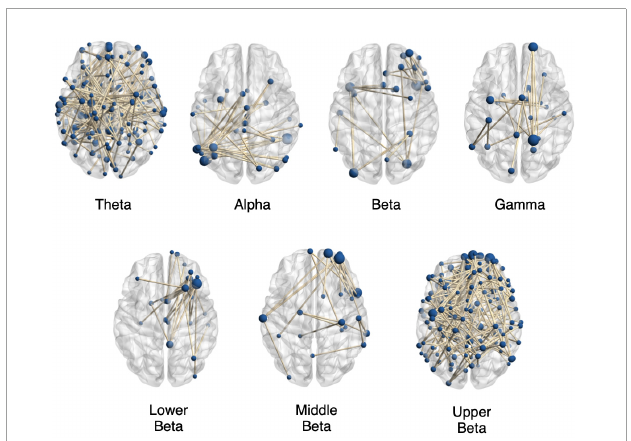
FIGURE2 Significantly altered brain networks in the autistic (autistic) group compared to the non-autistic group. The figure shows exemplary plots of networks with significantly altered functional connection strengths from various time windows during the FER task for positive emotions in the various EEG frequency bands for task 3.2 Investigation of Altered Functional Networks. The plots contain altered brain networks found for the theta band in 1–3 s time window with decreased connectivity ( p = 0.035); with decreased connectivity in the alpha band in 3–5 s time window ( p = 0.023); with decreased connectivity in the beta band during 1–2 s ( p = 0.029) and with increased connectivity in the gamma band in the 3–5 s time window ( p = 0.040). Also shown are examples of altered networks in the beta sub-bands with decreased connectivity in the autistic group compared to the non-autistic cohort in the lower beta band ( p = 0.025) in 1–2 s time window, decreased connectivity in the middle beta band ( p = 0.015) during 1–3 s time window and decreased connectivity in the upper beta band ( p = 0.036) during 1–3 s time window. The plots only show binary connections on the axial plane, connecting nodes lying in varying depths. The sizes of the nodes are proportional to the number of nodes connecting them. All plots were obtained using BrainNet Viewer toolbox (43).